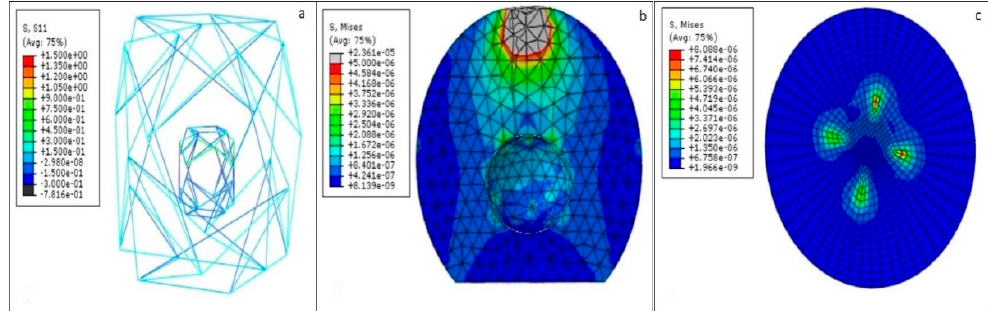
Figure 4. Stress distribution in the cell components: ( a ) principal stress in the cytoskeleton (CSK) and nucleoskeleton (NSK), the bar elements can be seen in dark color. ( b ) Principal stress in the cytoplasm. ( c ) Principal stresses on the substrate at the contact points between the CSK and substrate.